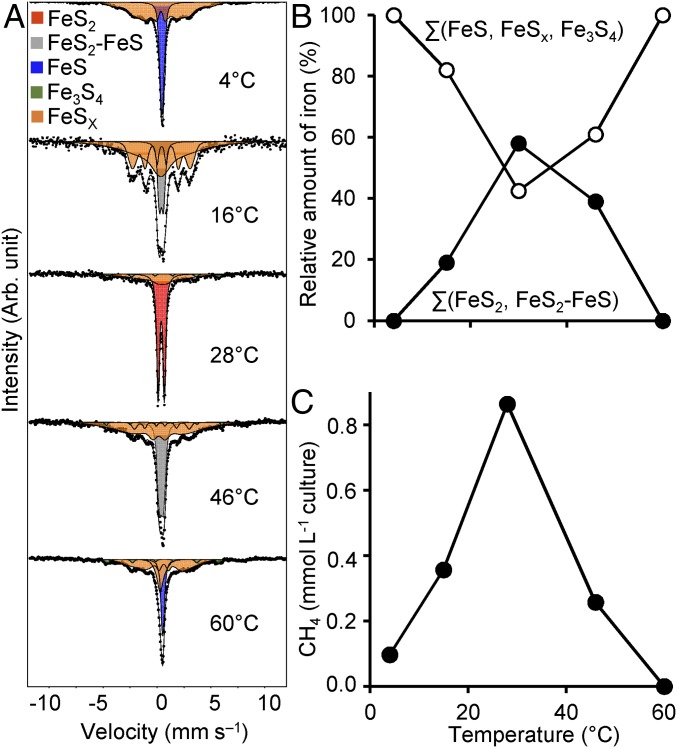
Temperature-dependent pyrite and methane formation in culture J5 after nearly 7 mo of incubation (207 d). (A) Mössbauer spectra showing the temperature-dependent iron−sulfur mineral composition (FeS2 in red, an intermediate FeS2−FeS phase in gray, FeS in blue, Fe3S4 in green, and intermediate FeSx phases in orange). Black dots represent the measured raw data. Corresponding black lines represent the sum of all fitted mineral phases. (B) Relative abundance of pyrite in comparison with all other measured iron−sulfur minerals plotted against temperature as the explanatory variable. Details are provided in SI Appendix, Table S2. (C) Average amount of methane (n = 2) plotted against temperature as the explanatory variable.